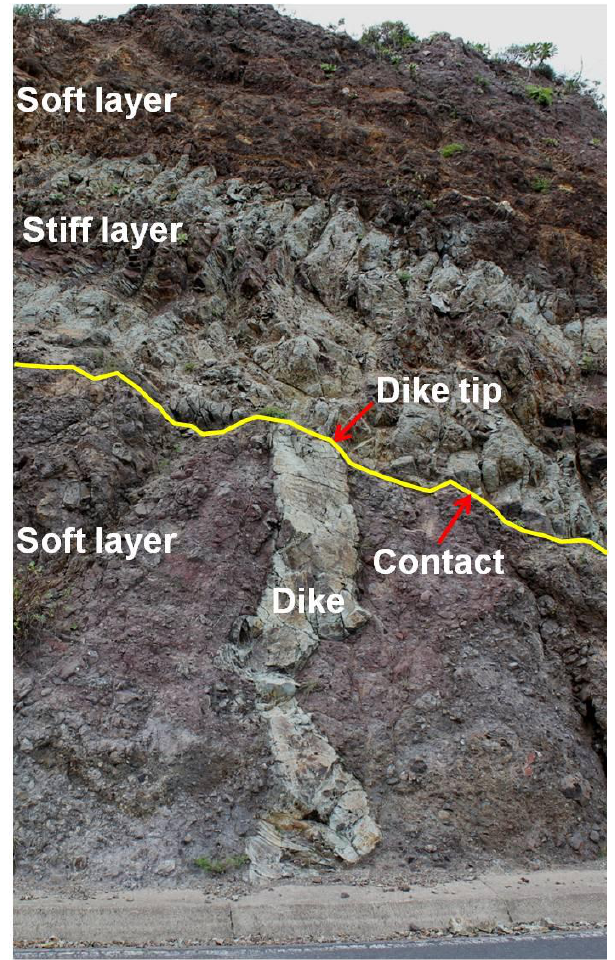
Fig. 8. Arrested basaltic dike at a contact between dissimilar rocks in Tenerife, Canary Islands. The stiff host rock is an inclined, basaltic sheet, whereas the soft rocks are altered breccias. The maximum dike thickness is 0.8 m.